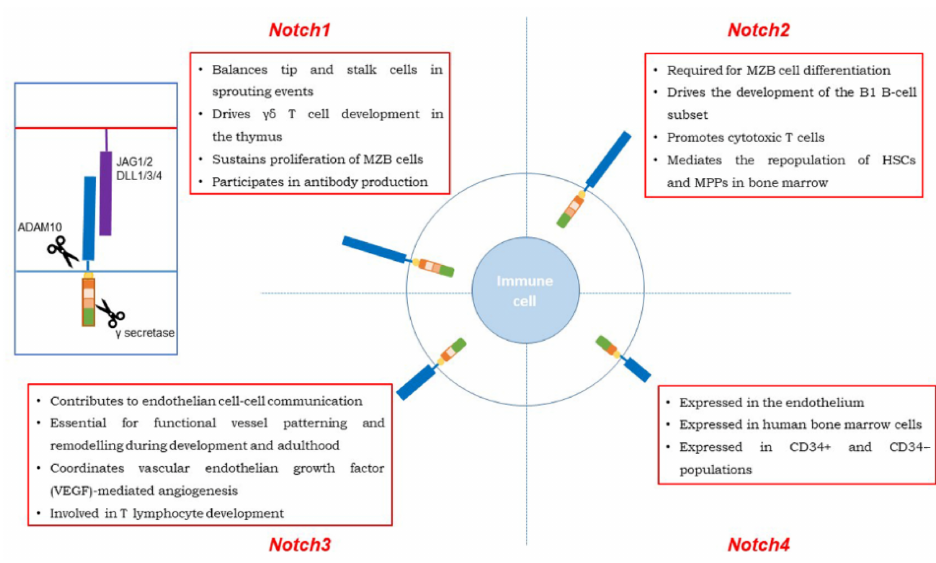
Figure 2. Scheme of all Notch receptors and their physiologic